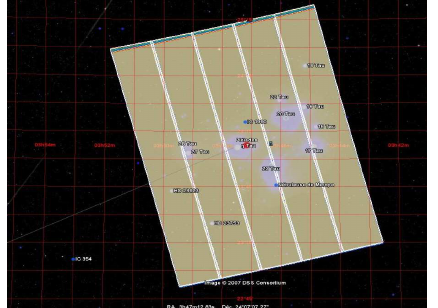
Figure 2 : example of zone of interest: the Pleiades